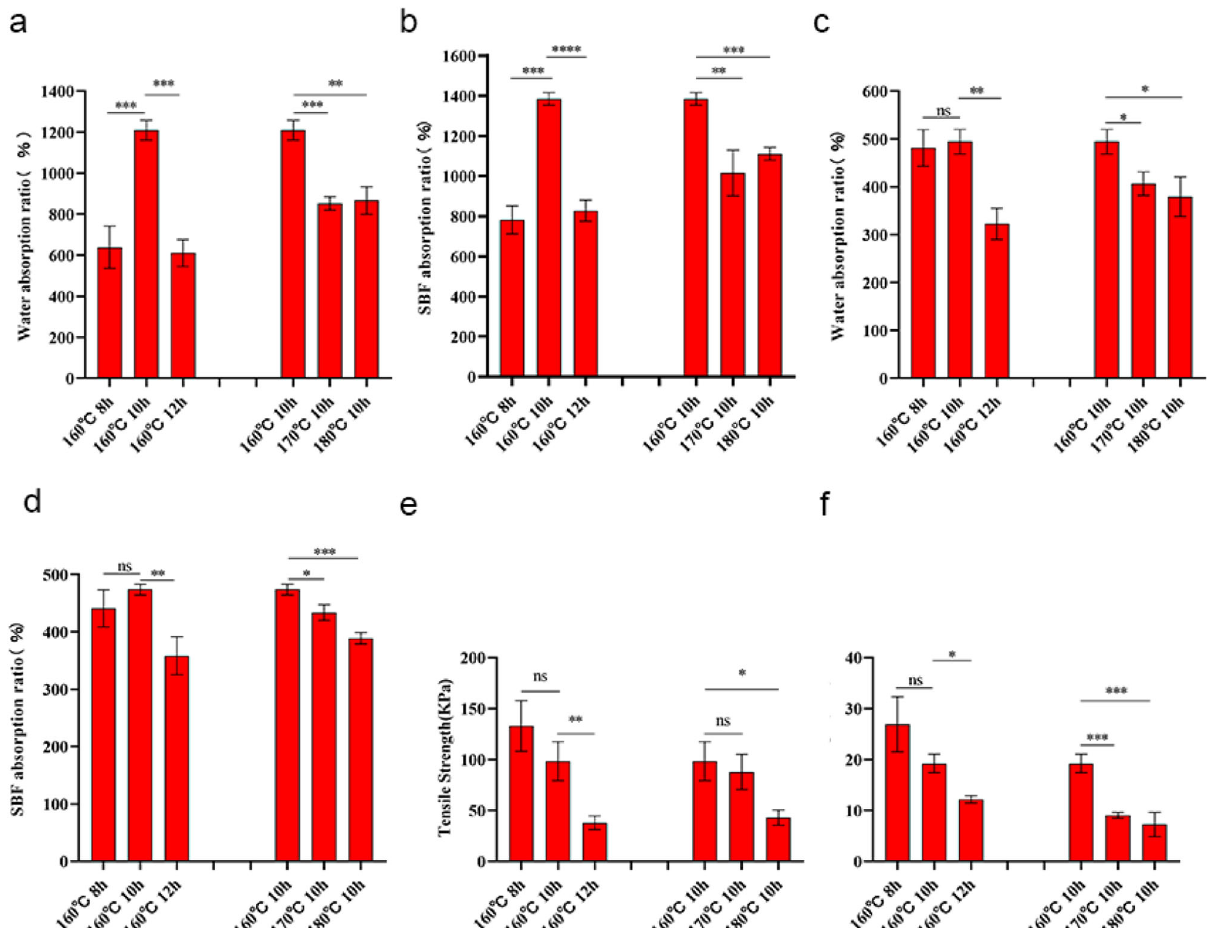
Fig. 1 Absorption capacity and tensile capacity of JFA and ZnO/JFA. a Water absorption capacity of JFA, b SBF absorption capacity of JFA, c Water absorption capacity of ZnO/JFA, d SBF absorption capacity of ZnO/JFA, e Tensile capacity of JFA, f Tensile capacity of